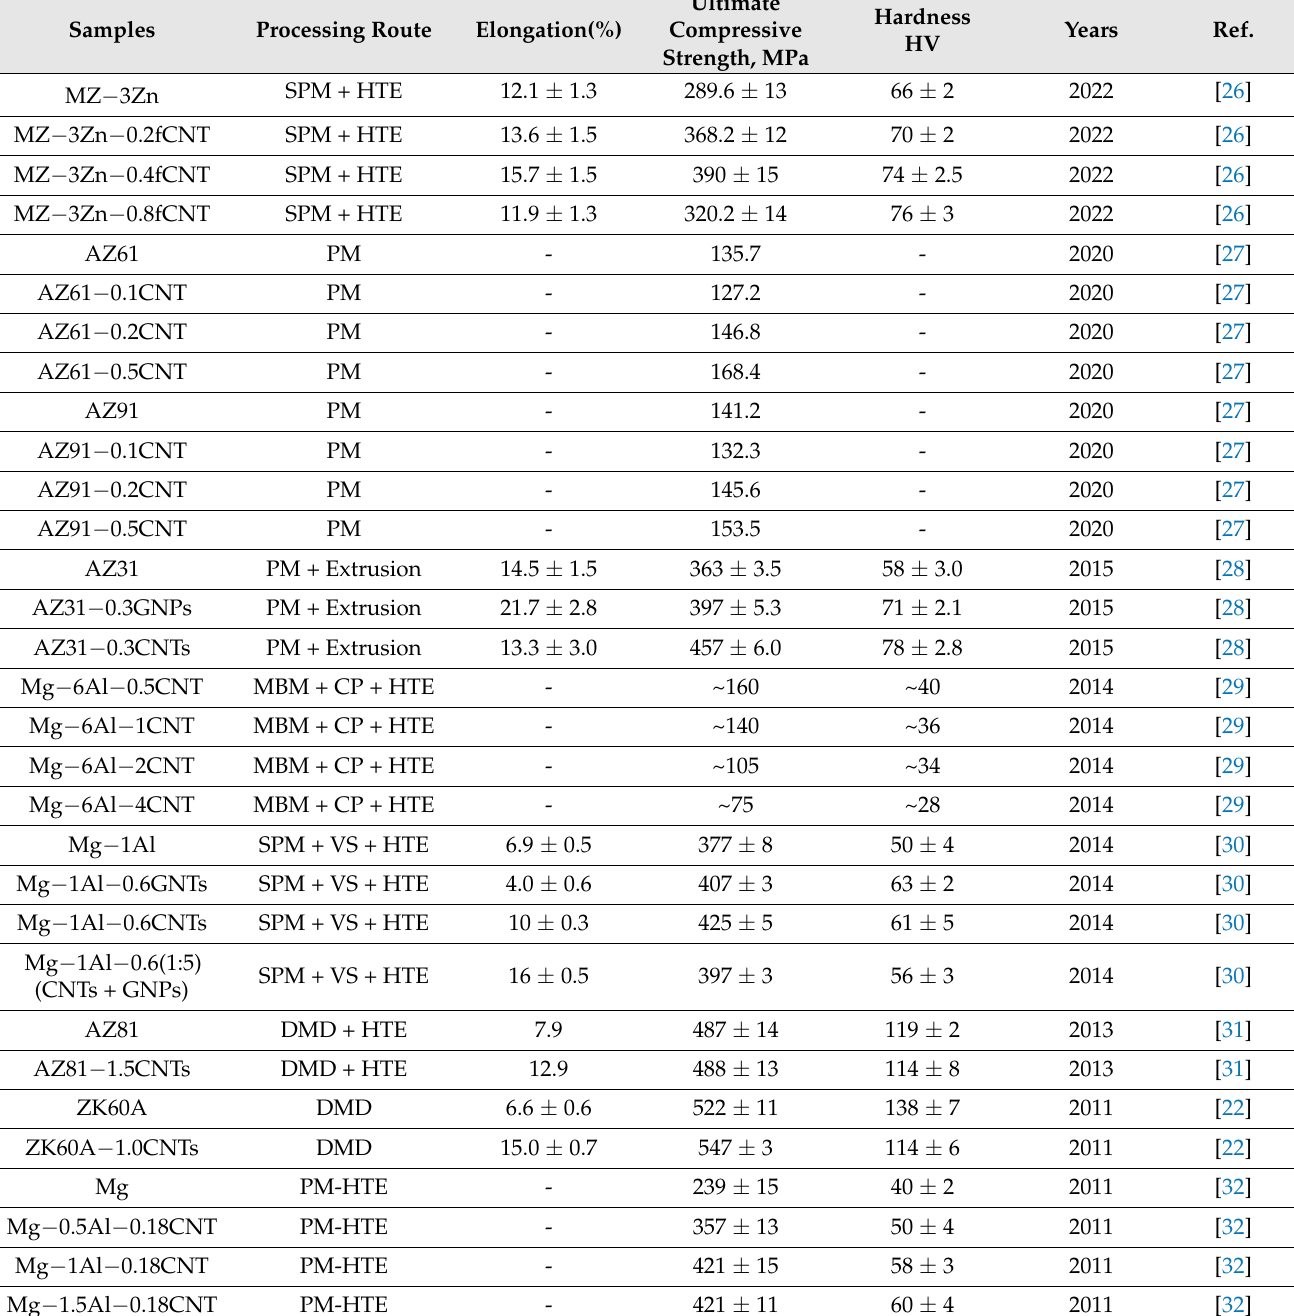
Table 1. A summary of the mechanical reinforcement performance of CNTs in Mg-based